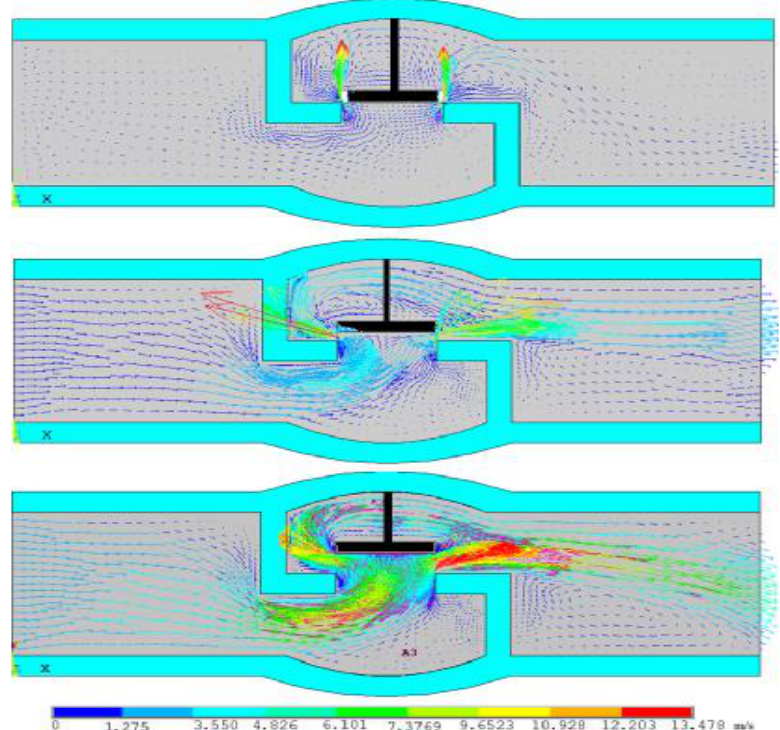
Fig. 7. Velocity vector distribution over the flow domain of globe valve at different enclosure ratio.